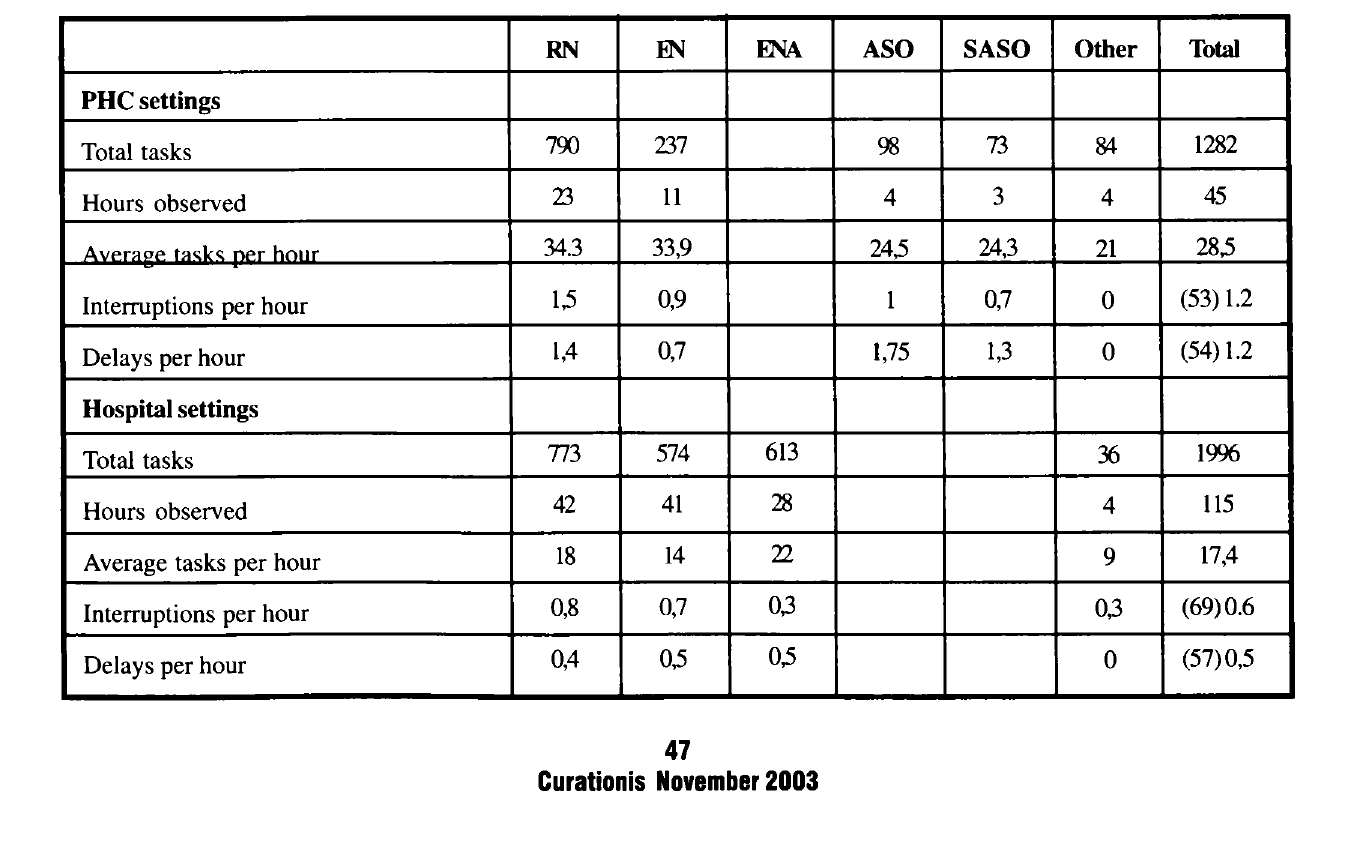
Table 2.4 Frequency of tasks, interruptions and delays in PHC and Hospital settings per